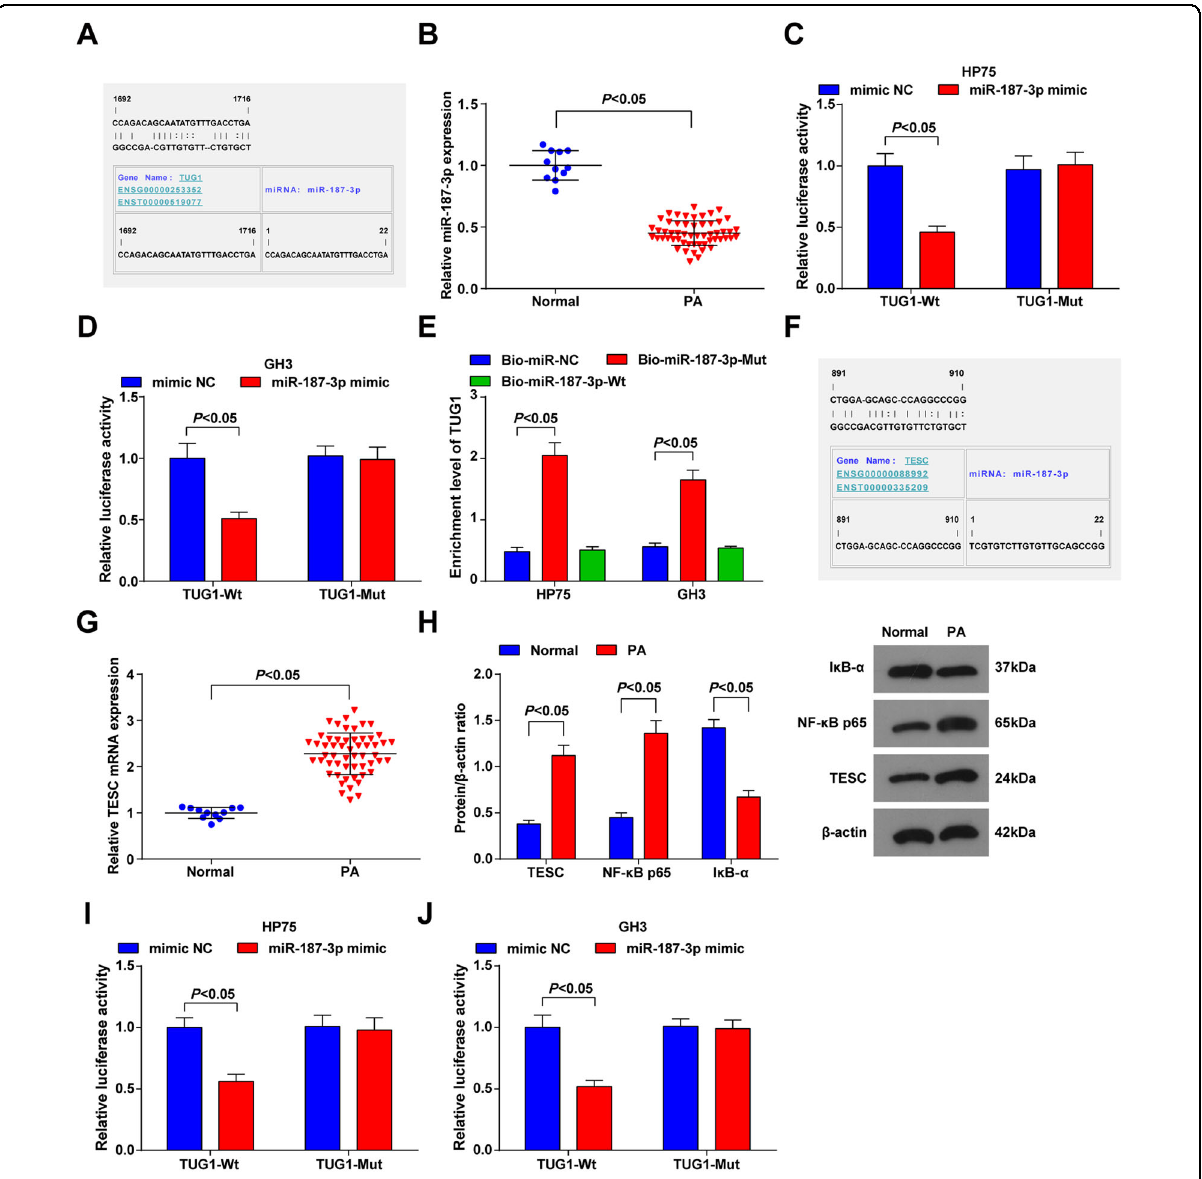
HP75 cells was con fi rmed by dual luciferase reporter gene assay; D regulatory relation between TUG1 and miR-187-3p in GH3 cells was con fi rmed by dual luciferase reporter gene assay; E regulatory relation between TUG1 and miR-187-3p in GH3 and HP75 cells was con fi rmed by RNA pull-down assay; F binding sites of miR-187-3p and TESC were predicted by a bioinformatic website; G TESC mRNA expression in PA tissues was detected using RT-qPCR; H expression levels of TESC, NF- κ B p65 and I κ B- α in PA tissues were detected using western blot analysis; I target relation between miR-187- 3p and TESC in HP75 cells was con fi rmed by dual luciferase reporter gene assay; J target relation between miR-187-3p and TESC in GH3 cells was con fi rmed by dual luciferase reporter gene assay. n = 11 in the normal group and n = 55 in the PA group. Repetitions = 3, Data are presented as mean ±